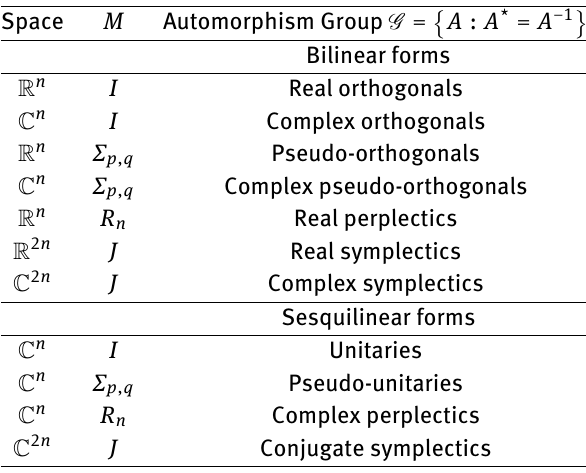
Table 2: Matrix groups associated with certain bilinear and sesquilinear